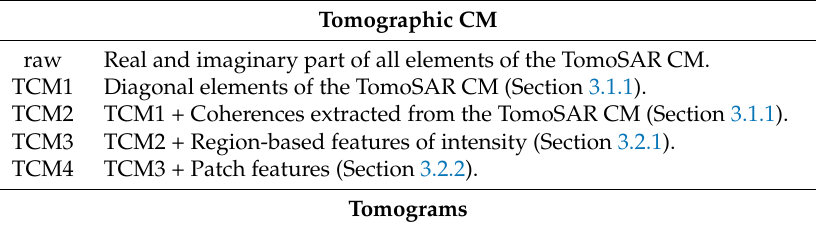
Table 1. Summary of the different feature groups based on polarimetric and tomographic covariance matrices, i.e., PCMx and TCMx, respectively, as well as on tomograms, i.e.,